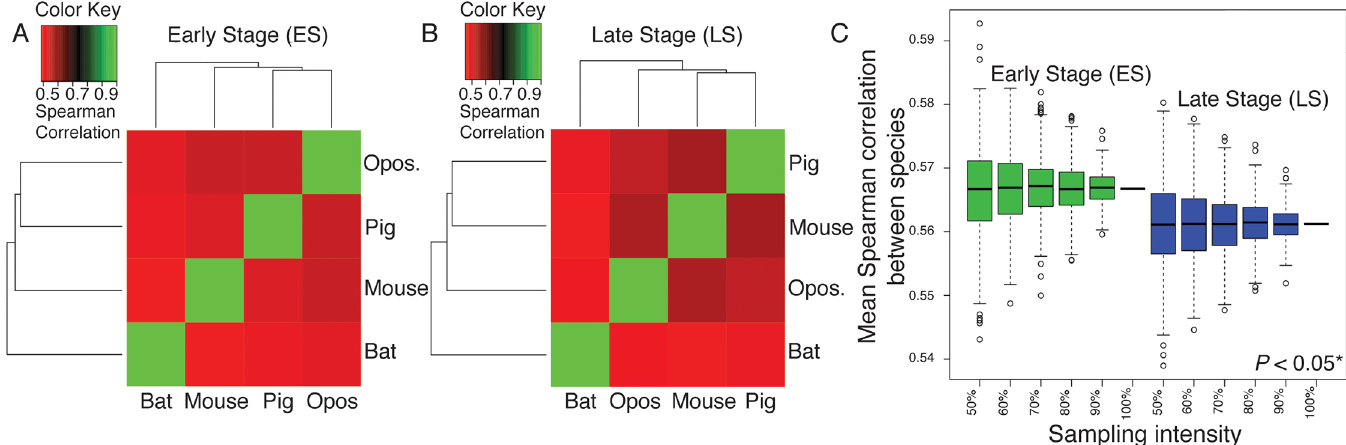
Fig 4. Overall patterns of gene expression are positively correlated among all examined mammals during the Early (ES; A) and Late (LS; B) stages of limb development. Opos. = opossum. (C) The Mean Spearman correlation of gene expression patterns between species is higher for the Early (ES) than Late (LS) stage of limb development. This difference is significant ( P < 0.05) when more than 90% of orthologous genes are sampled (indicated by asterisks). Whiskers represent the 95% confidence intervals for the